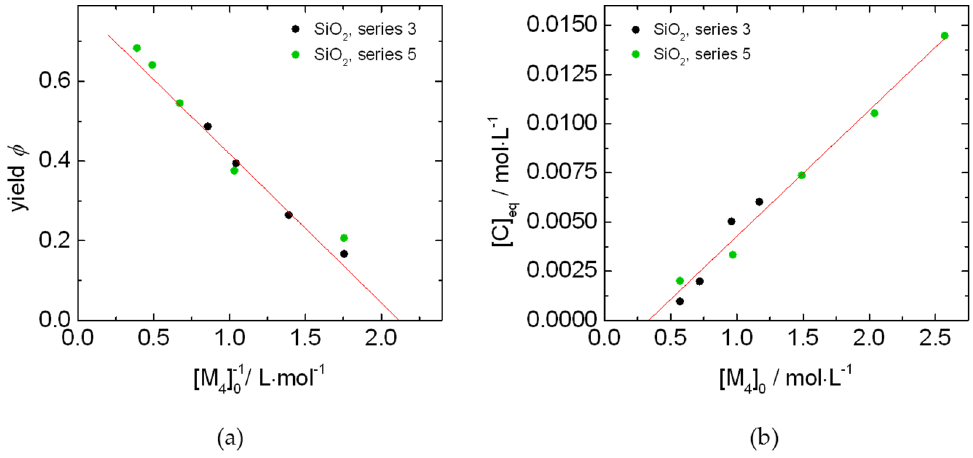
Figure 5. ( a ) Yield Φ as a function of the reciprocal monomer concentration and ( b ) polymer concentration from SI–ROP of M 4 with SiO 2 particles as a function of (cid:4670)M (cid:2872) (cid:4671) (cid:2868) for Series 3 and 5.